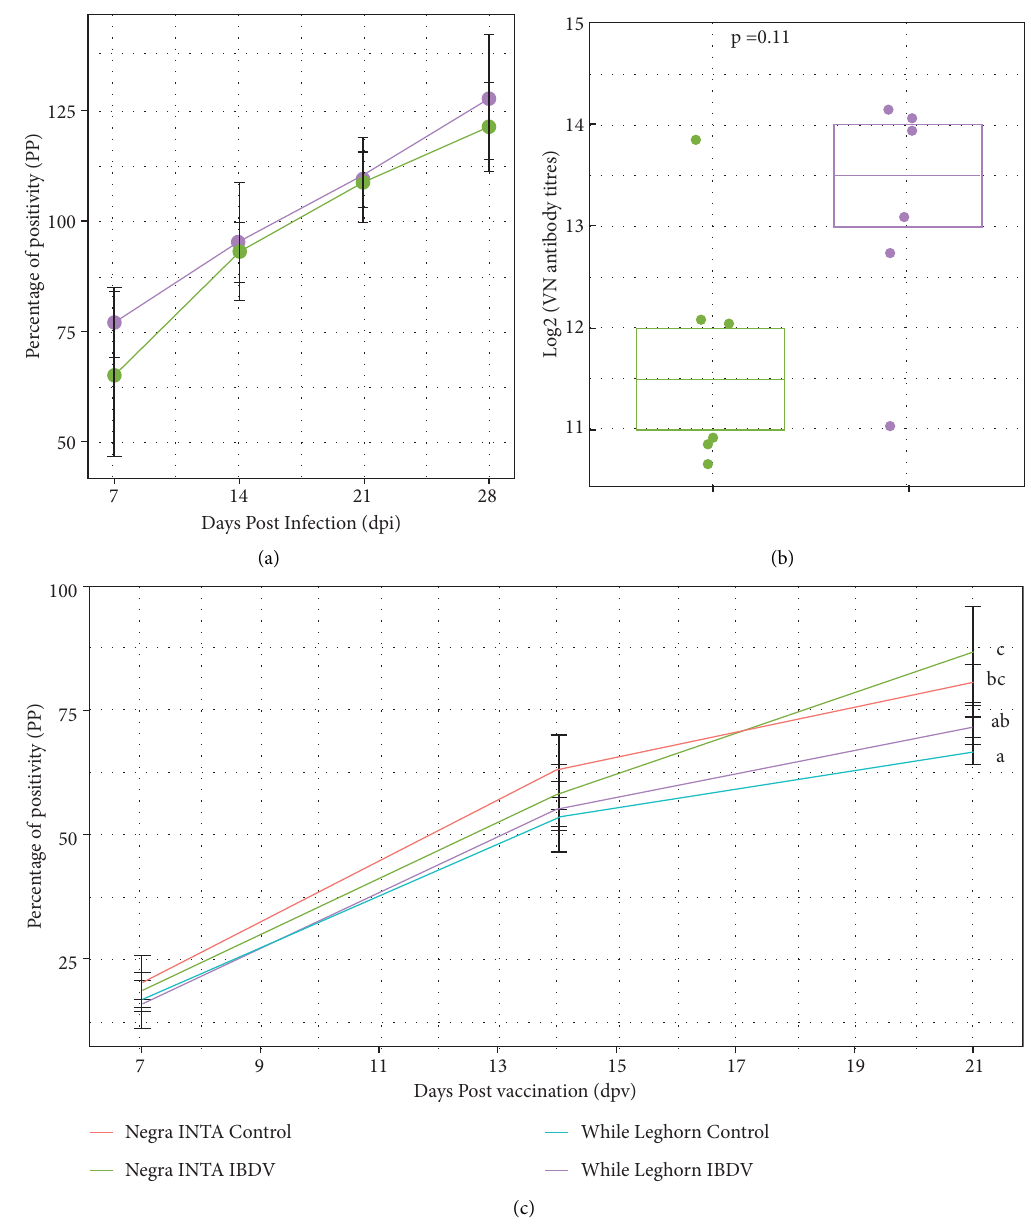
Figure 4: Anti-IBDV and anti-NDV humoral immune responses. (a) Percentage of positivity (PP) of anti-IBDV antibodies at 7, 14, 21, and 28dpi obtained with an indirect ELISA. Te mean PP values ± SD are shown for each group at the diferent time points; data from the negative controls of infection were less than 15% (data not shown). (b) IBDV neutralizing antibody titers in IBDV-infected chickens at 28dpi, calculated as the inverse of the last dilution showing no cytopathic efect. Log2 of the median of each group is shown and the comparisons were made using Wilcoxon–Mann–Whitney, p < 0 . 05. (c) Percentage of positivity (PP) of anti-NDV antibodies in sera collected at 7, 14, and 21 days postvaccination with NDV measured with an in-house ELISA. Data from the negative controls of NDV vaccination were less than 15% (data not shown). Diferent letters indicate signifcant diferences among groups at day 21 (one-way ANOVA test and Tukey post-hoc test, p < 0 .